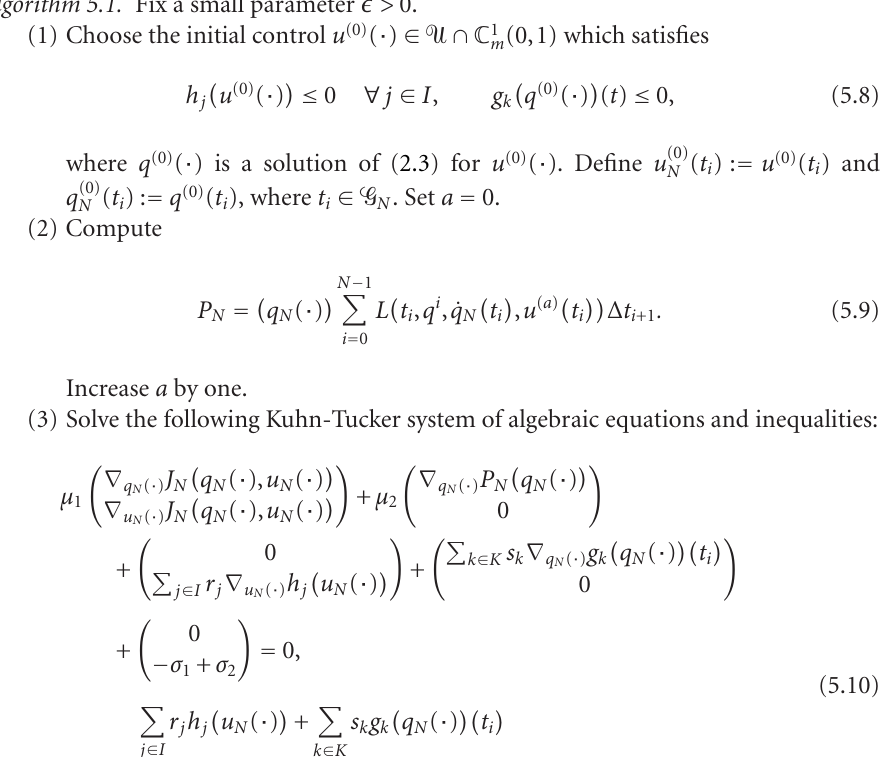
Algorithm 5.1. Fix a small parameter (cid:2) >